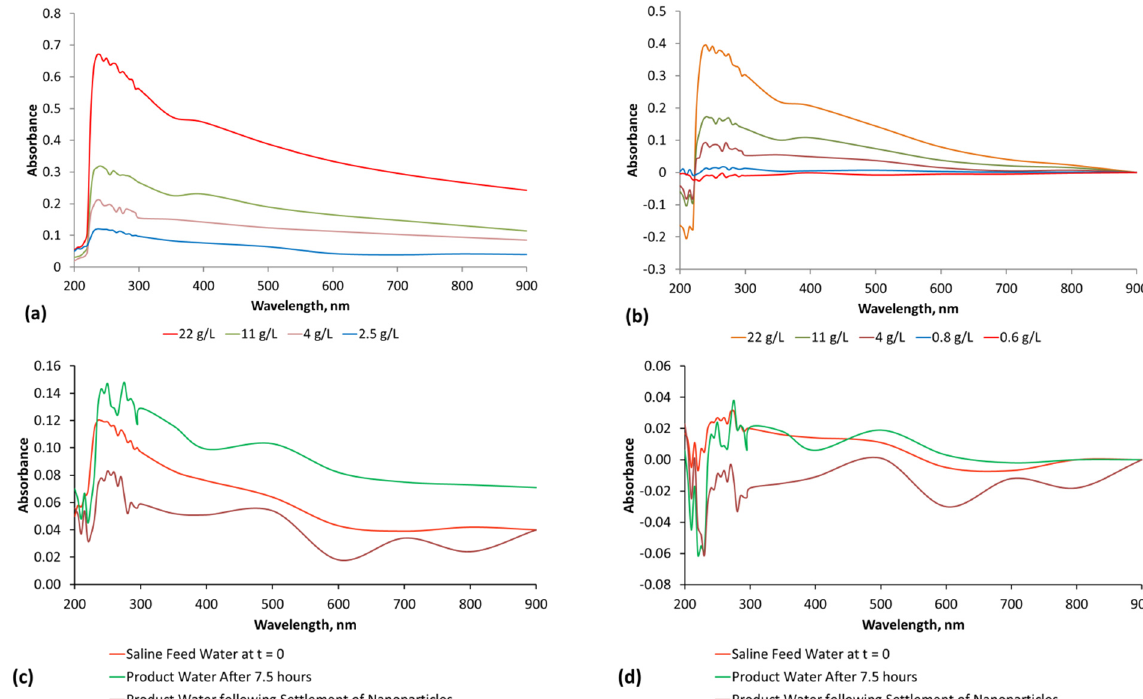
Figure E1. Absorbance (relative to reference freshwater control sample) vs. wavelength for different concentrations of halite (g·L − 1 ). ( a ) Raw control data set, absorbance relative